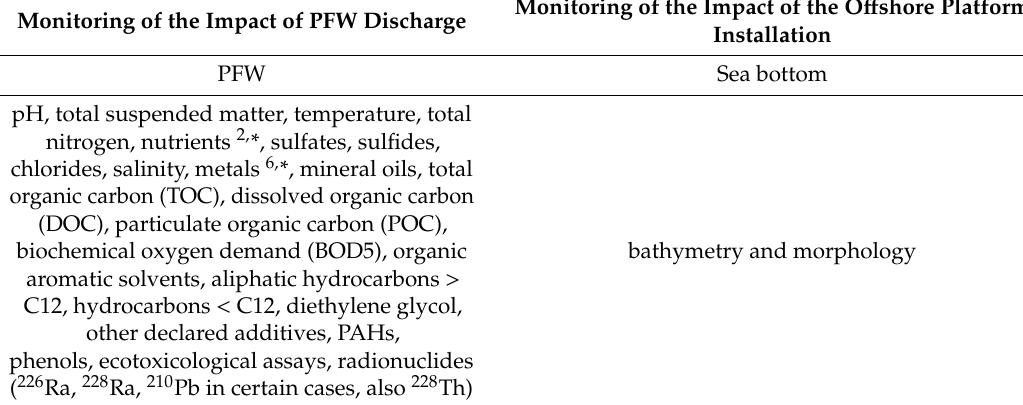
Table S1: Questionnaire on platform installation EIA procedures; Table S2: Questionnaire on Produced Formation Water discharge EIA procedure; Table S3: Questionnaire on monitoring procedure of impacts due to platform installation and Produced Formation; Table S4: Questionnaire on o ff shore plaftorm decommissioning